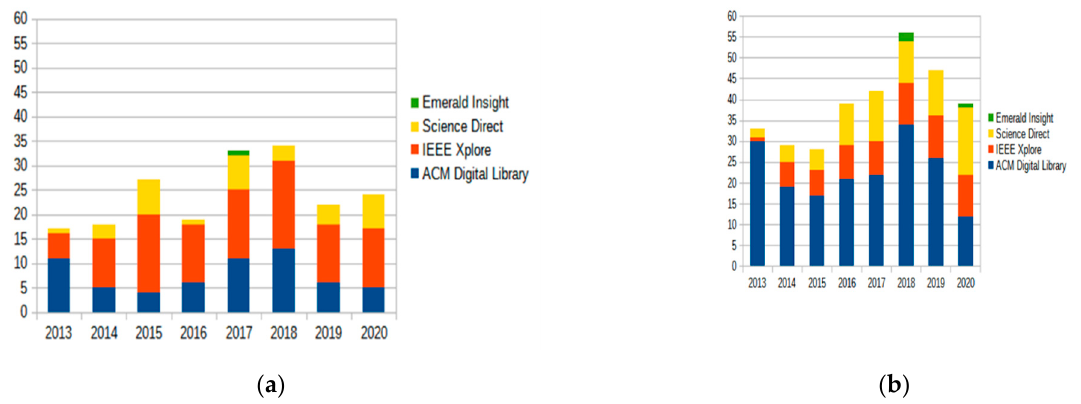
Figure 1. ( a ) Popularity of sensor open data-related studies by digital library between 2013 and 2020; ( b ) Popularity of real-time open data-related studies by digital library between 2013 and